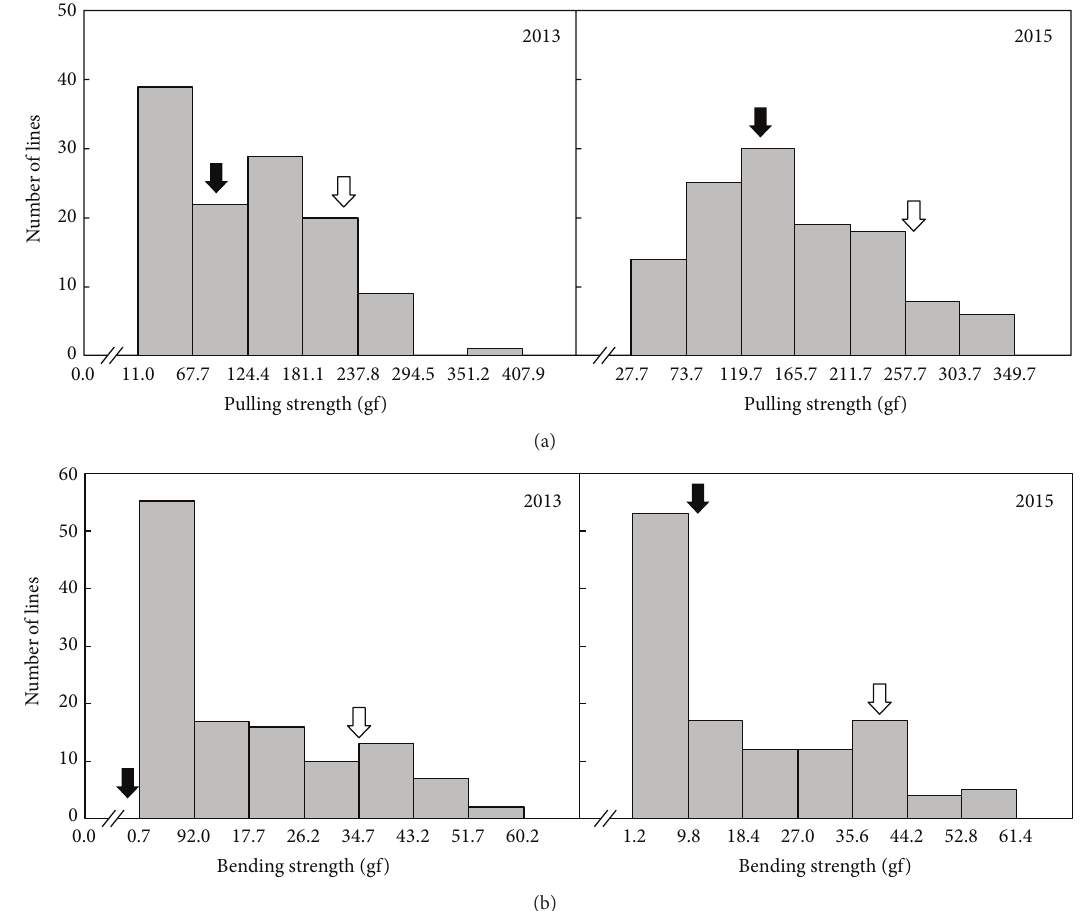
Figure 2: The frequency distribution for BTS in DH population. BTS was measured as pulling strength (a) and bending strength (b) for two years. The black arrows are represented as Cheongcheong while the white arrow indicates Nagdong.